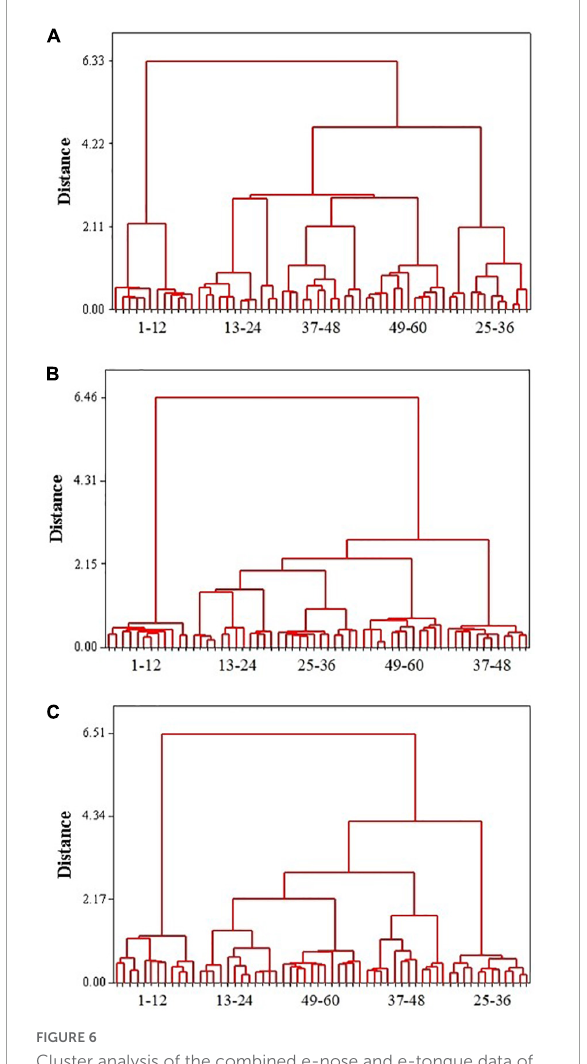
FIGURE6 Cluster analysis of the combined e-nose and e-tongue data of seasoning powder (A) , seasoning mixture sauce (B) , and the mixture of powder and sauce (C) . 1–12, C brand; 13–24, D brand; 25–36, G brand; 37–48, L brand; 49–60, Z